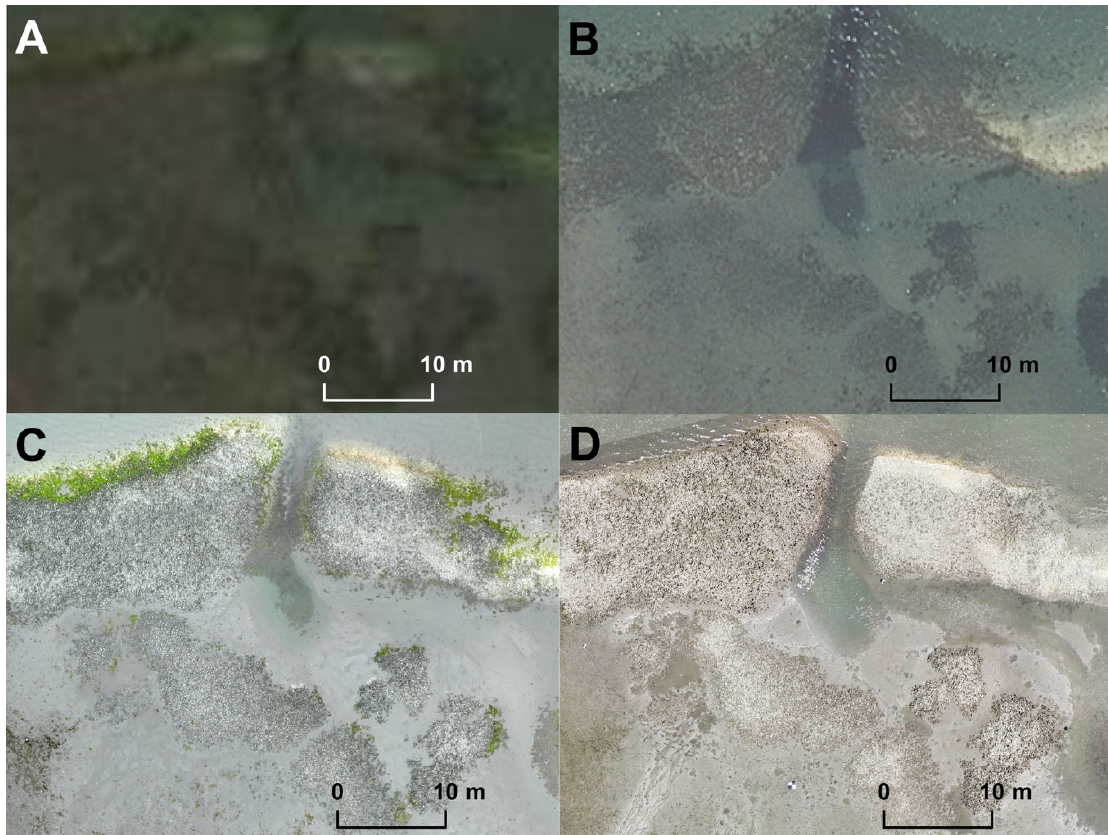
Figure 1. Comparison of imagery used to assess intertidal oyster reefs with the same scale and extent on Town Marsh, Rachel Carson Reserve, part of the North Carolina National Estuarine Research Reserve (NCNERR), Beaufort, NC. ( A ) Google Earth imagery, as used by Grizzle et al. (2018) [26]. ( B ) 0.15 × 0.15 m high-resolution orthoimagery taken February 2012 and accessed from United States Geological Survey (USGS) Earth Resources Observation and Science (EROS) Archive. ( C ) 0.02 × 0.02 m resolution unoccupied aircraft systems (UAS) imagery from an eBee fixed-wing flight taken in March 2018. ( D ) 0.006 × 0.006 m resolution UAS imagery from a DJI Mavic Pro multicopter flight taken in May 2018.